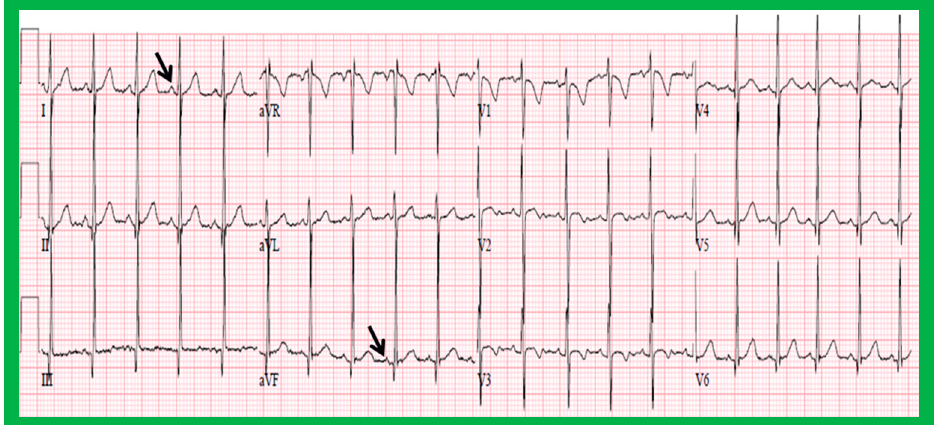
Figure 17. Electrocardiogram (ECG) of a patient illustrating normal P waves, namely, positive P waves in both leads I and AVF (axis of +45 degrees), which suggests normal atrial position; situs solitus. The ECG also shows normal Q waves in both leads V5 and V6 and no Q waves in leads in both V1 and V2; these data suggest a normal relationship of ventricles with the right ventricle on the right side and left ventricle on the left side. Reproduced from reference [4].